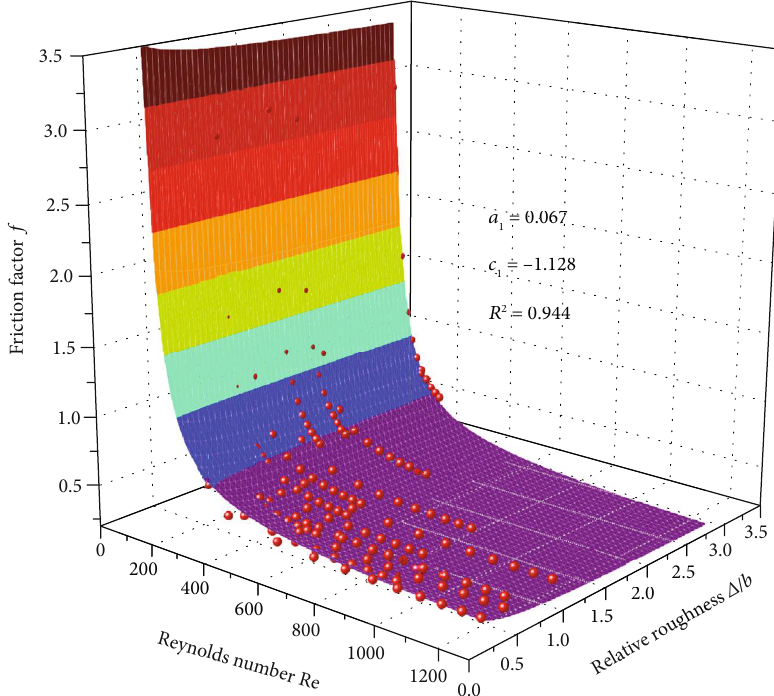
Figure 17: Relationship of f ~ Re and relative